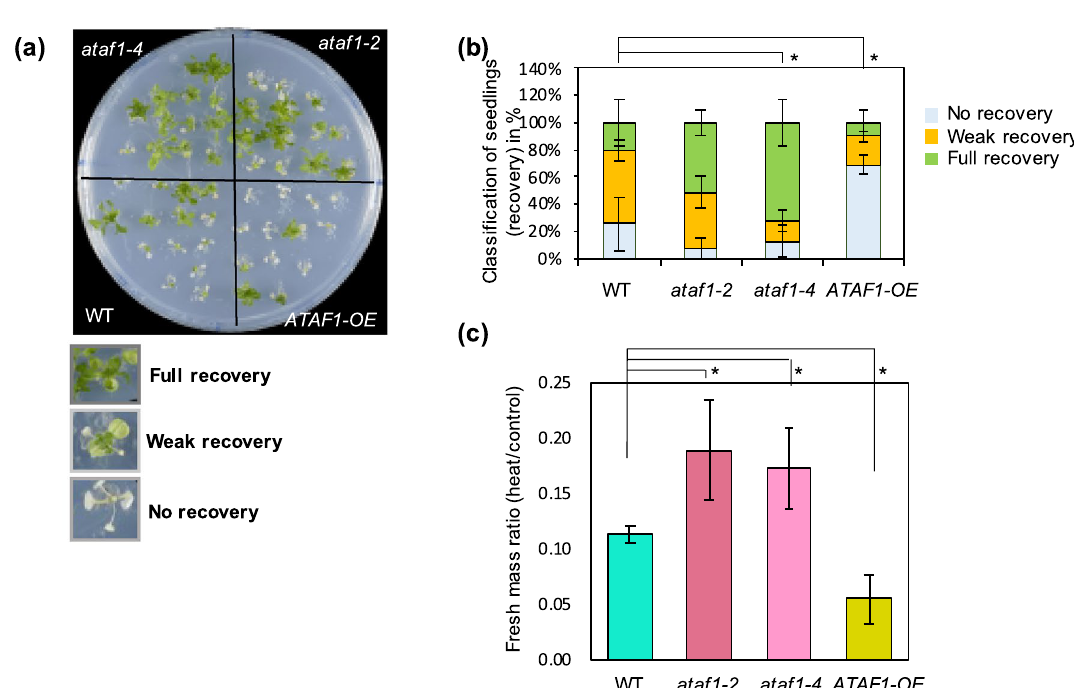
Figure 3. Improved thermomemory in ataf1 mutants . ( a ) Thermomemory phenotype of ATAF1 transgenic plants. Seedlings of ATAF1- OE, ataf1-2 , ataf1–4 , and WT were exposed to the HS regime schematically shown in Fig. 1a. Photos were taken 14 days after the second HS (triggering stimulus). The phenotype of one representative replicate of at least three independent biological replicates is shown. ( b,c ) Quantification of the results shown in ( a ). ( b ) Percentage of seedlings in different phenotypic classes; the thermotolerance phenotype was classified into three classes depending of the extent of plant recovery. The phenotype classes are illustrated in panel ( a ). ( c ) Seedling fresh mass in HS-primed and triggered plants compared to unstressed control plants. Error bars represent the standard deviation, calculated from three biological replicates; each replicate is the average mass of 13 seedlings. Significant differences between transgenic and WT plants were calculated using Student’s t -test; *indicates P -value <